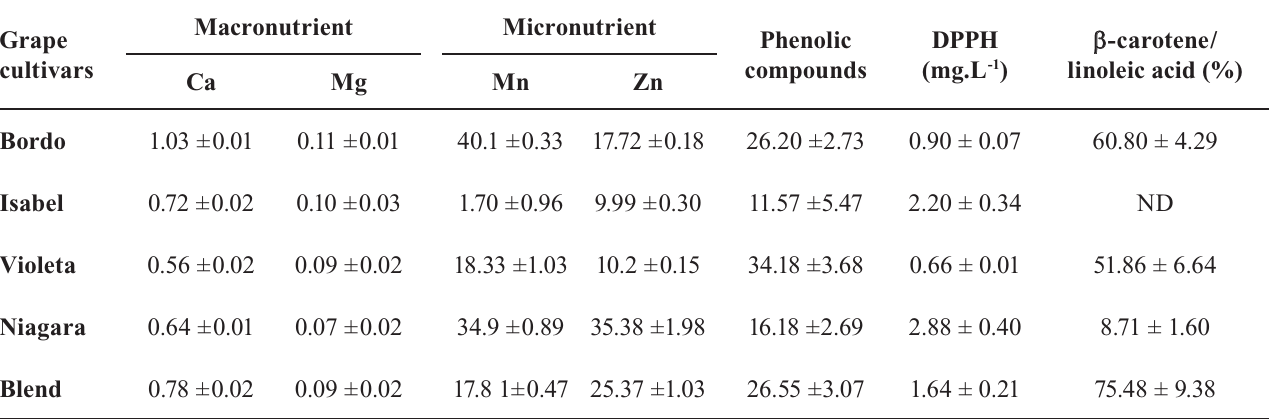
TABLE I - Macronutrient contents (Ca and Mg, expressed in g 100g -1 ), micronutrients (Mn and Zn expressed in mg Kg -1 ) total phenolic compounds (g 100g -1 ) and antioxidant activity in pomace from grape